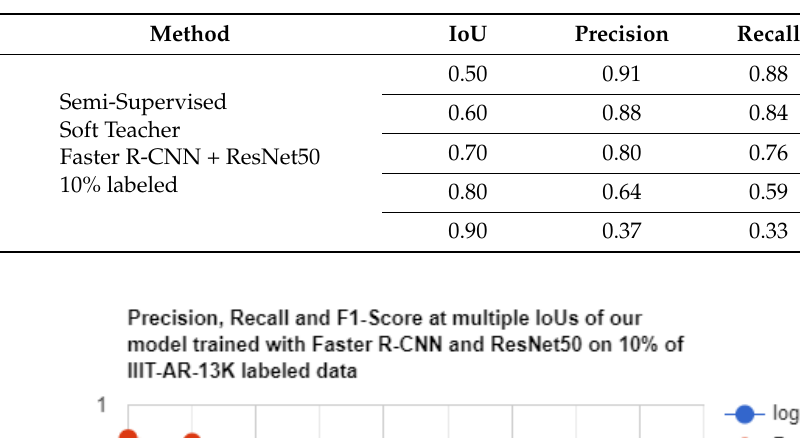
Table 12. A detailed representation of Precision, Recall and F1-Score at multiple IoUs. Our model is